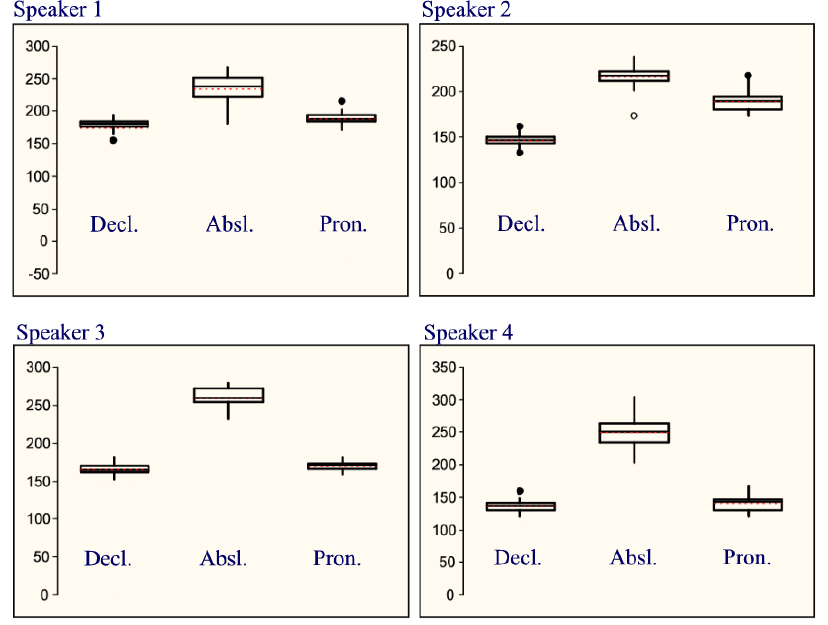
Figure 5. Box plots of nuclear pitch accent Low tones of all three utterance types in Hz